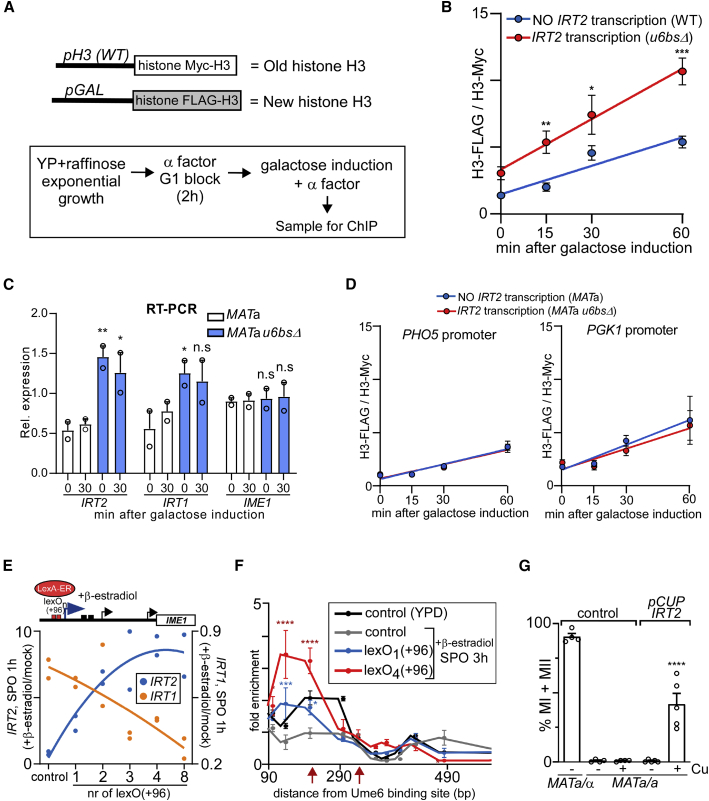
IRT2 transcription has a level-dependent effect on local chromatin and transcription states(A) Scheme for measuring histone H3 exchange rates.(B) Histone H3 exchange rate at the IRT1 promoter in the presence or absence of IRT2 transcription. A strain harboring differentially epitope-tagged histone H3, with one copy expressed from the endogenous promoter (Myc-H3) and the other expressed from a GAL1-10 inducible promoter (pGAL-FLAG-H3) were used for the analysis. Constitutive low levels of IRT2 transcription are achieved using the u6bsΔ mutation (FW7880), whereas WT cells (FW7853) display no IRT2 transcription in rich medium (YP). Cells were grown till mid-log in YP raffinose and arrested in G1 with α factor, and FLAG-H3 was induced with galactose. The signals for H3 ChIP (Myc-H3 and FLAG-H3) were normalized to a telomere locus, and ratios for n = 3 (error bars represent ±SEM) are displayed. ∗p < 0.05; ∗∗p < 0.005; and ∗∗∗p < 0.0005, on a two-way ANOVA followed by Fisher’s LSD test. The slopes of the linear regression equations (Y = [0.07105 ⋅ X] + 1.466 for control, and Y = [0.1258 ⋅ X] + 3.325 for u6bsΔ) are significantly different.(C) Relative expression of IRT2, IRT1, and IME1 in cells and grown as described in (B). qPCR signals were normalized to ACT1. Error bars represent ±SEM; n = 2. ∗p < 0.05; ∗∗p < 0.005, on an unpaired Student’s t test.(D) Similar to (B), histone exchange at the PHO5 and PGK1 control promoters in strains described in (B). Error bars represent ±SEM; n = 3. The slopes of the linear regression equations for both loci are not significantly different.(E) Scheme for controlling different levels of IRT2 by LexA-ER (top). Multiple lexA operator (lexO) sequences were integrated in the IRT2 promoter at +96 bp relative to IRT2 start site (lexO(+96)). LexA-ER is activated by β-estradiol. IRT1 and IRT2 levels as quantified by northern blot normalized to SCR1, in cells harboring 1, 2, 3, 4, and 8 lexO(+96) sites in the IRT2 promoter (FW6594, FW6599, FW6607, FW6611, and FW6619) at 1 h in SPO. The MATa LexA-ER control strain (control, FW6560) was included. Cells were treated (+β-estradiol) or not (mock) for 3 h and shifted to SPO plus β-estradiol. The ratio of +β-estradiol/mock is displayed. n = 2 data points and a trend line representing second-degree polynomial fit are shown.(F) Chromatin structure at the IRT1 promoter in the presence of distinct levels of IRT2 transcription. Control cells (MATa LexA-ER, FW6560) or cells harboring 1 or 4 lexO(+96) sites (FW6594 or FW6611) were treated as described in (E). MNase-digested fragments were subject to qPCRs using primer pairs nested in IRT2. The red arrows indicate the position of the Rme1 binding sites. The signals were normalized over a telomere locus. Error bars represent ±SEM; n = 3. ∗p < 0.05; ∗∗∗p < 0.0005; and ∗∗∗∗p < 0.0001, on a two-way ANOVA followed by Fisher’s LSD test performed on lexO strains compared to control SPO for 3 h.(G) MATa/α and MATa/a diploid cells (FW1511 and FW15) and MATa/a cells harboring pCUP-IRT2 (FW8923) were shifted to SPO and either treated (+Cu) or not (−Cu) with copper sulfate. DAPI masses were counted from cells fixed at 72 h in SPO. Cells harboring >2 DAPI masses were considered to have undergone meiotic divisions (MI + MII). Error bars represent ±SEM; n = 4 for the controls, and n = 5 for pCUP-IRT2. ∗∗∗∗p < 0.0001, two-way ANOVA followed by Fisher’s LSD test performed on MATa/a strains with or without copper sulfate treatment.